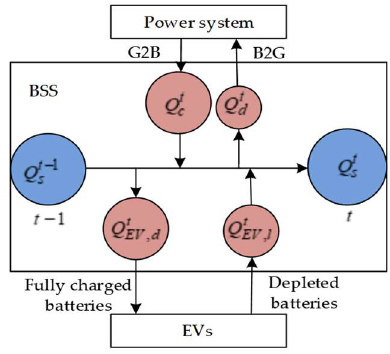
Figure 2. Main operation characteristics of a battery swap station.